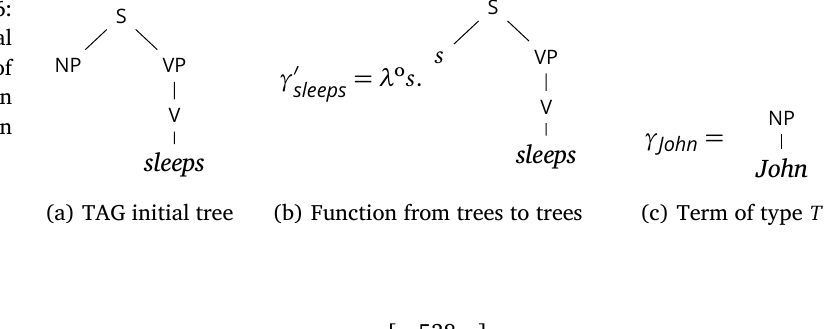
Figure 6: Functional interpretation of the substitution